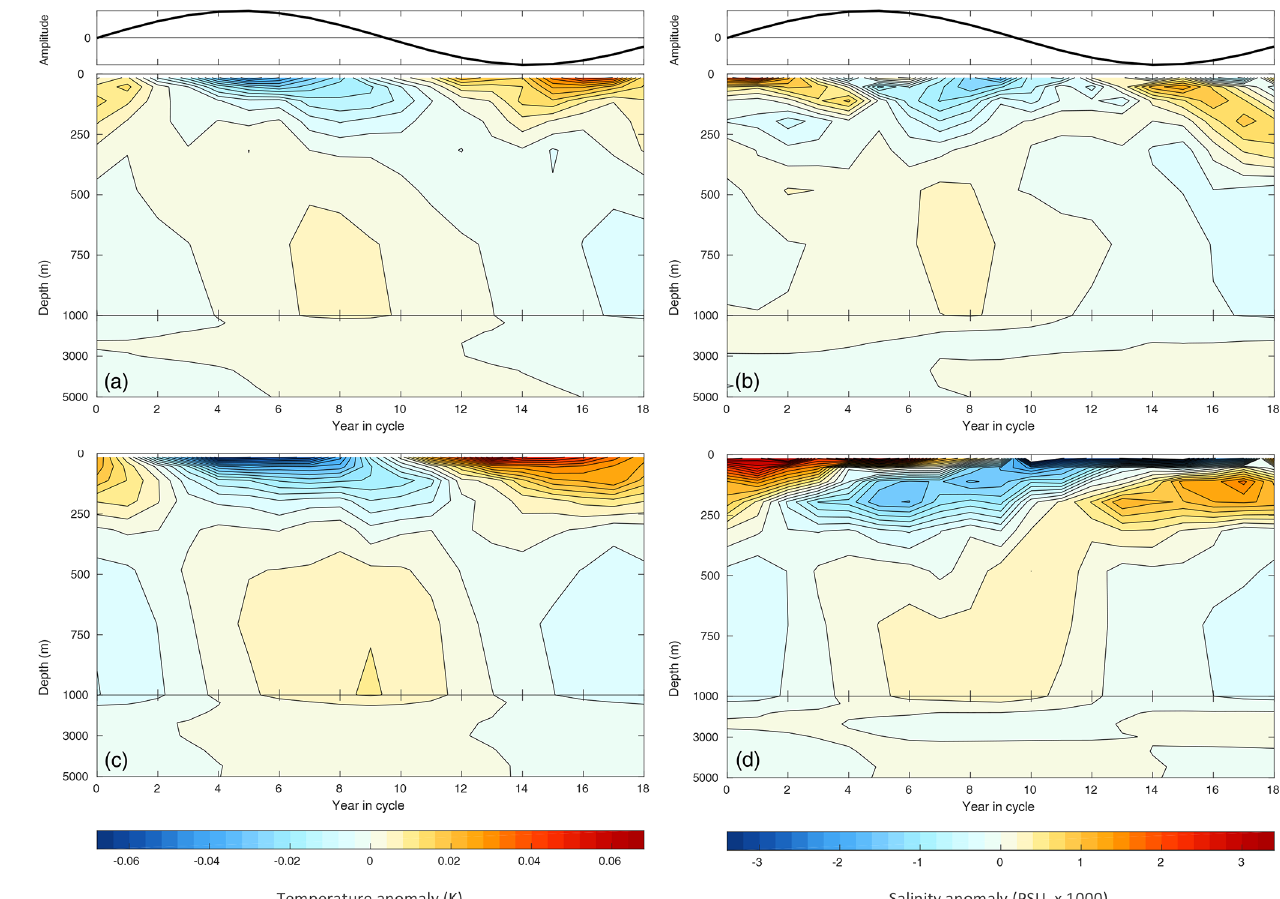
Figure 2. (a) Globally averaged variation of ocean temperature anomalies ( K ) vs. ocean depth and phase (years) in the scaled run. The phase coordinate describes the temporal modulation of the vertical diffusion shown in the inset at the top ( T ( t ) in Eq. 1) and in Fig. 1a; i.e. maximum diffusion is in year 5 and minimum diffusion is in year 14. (c) As panel (a) but for the constant run. (b) As panel (a) but for global salinity (PSU). (d) As panel (c) but for global